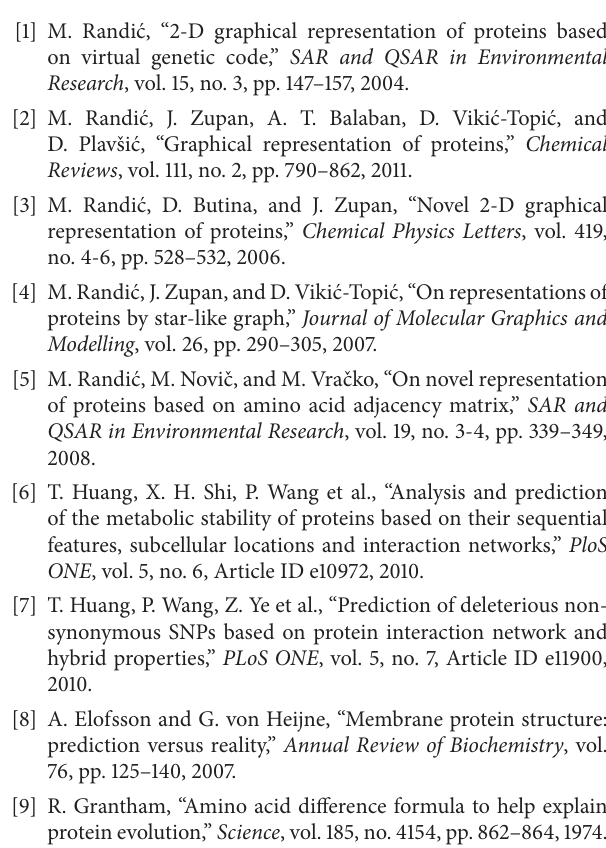
Table 3: Classification model using decagonal isometries matrix. Sets